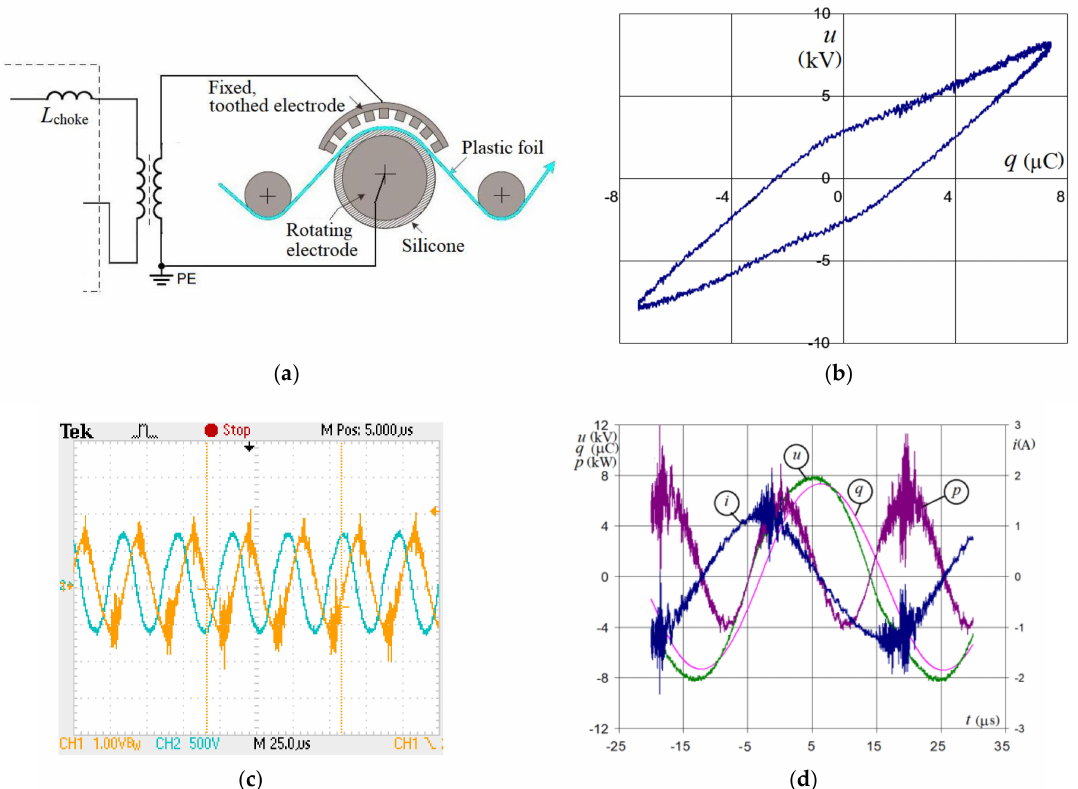
Figure 8. The discharge chamber for foil processing: ( a ) construction principle; ( b ) the trajectory u ( q ) obtained experimentally at the frequency 26.8 kHz of the inverter output voltage and power 1.5 kW; ( c ) oscillogram of electrode current and voltage at the frequency of 26.8 kHz, CH1 1 A / div., CH2 6.25 kV / div.; ( d ) waveforms of current, voltage, charge, and instantaneous power of the electrode set obtained from the data from the